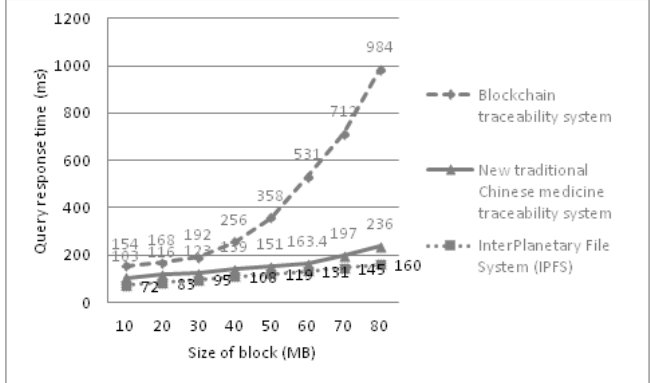
Figure 7. Comparison of the query response time changes with different sizes of block